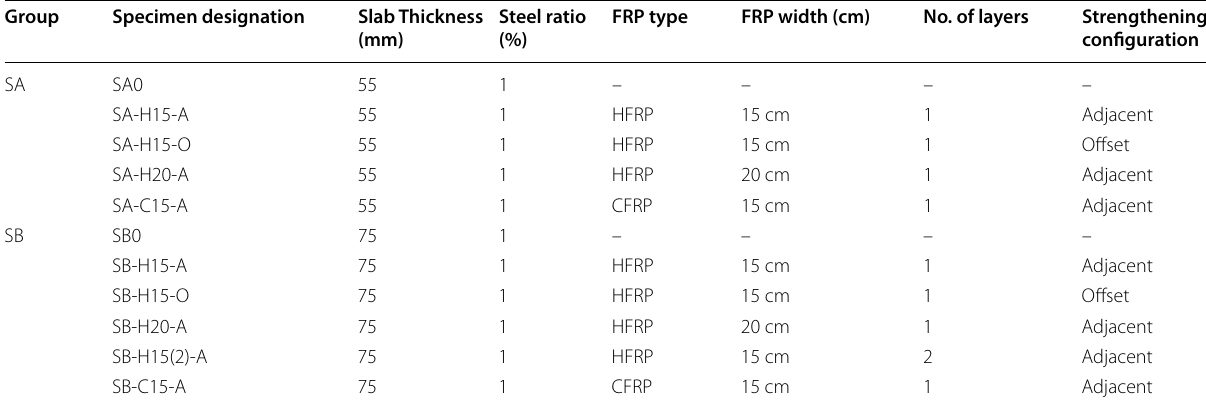
Table 1 Summary of test